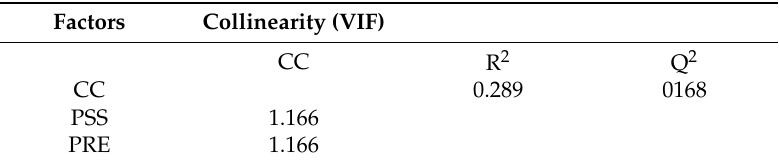
Table 3. Collinearity, R2 and Q2.